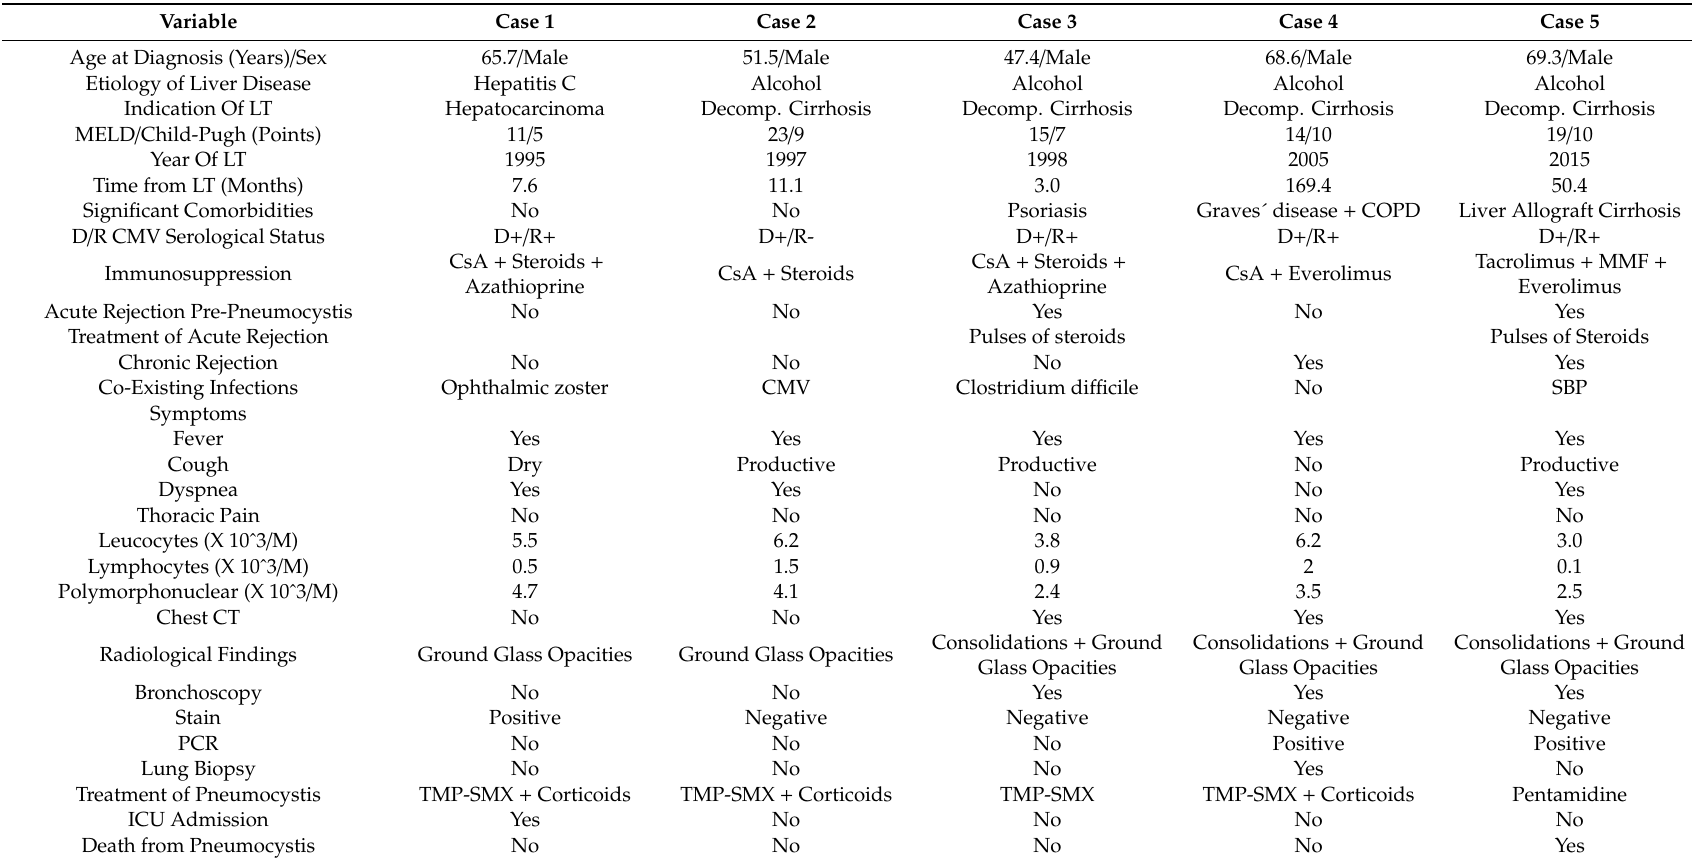
Table 3. Characteristics of patients with Pneumocystis jirovecii